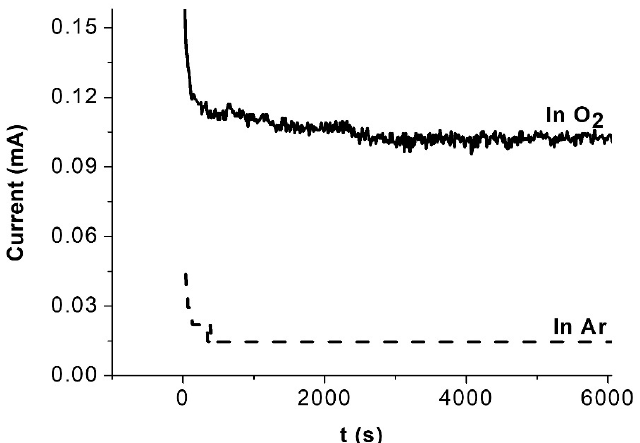
Figure 4. Potentiostatic stability tests of the Ni (20%)-NaPG/C catalyst on a CC electrode (S = 0.0707 cm 2 ) in 0.5 M H 2 SO 4 for 6000 s in both oxygen (solid, thick curve) and argon (dashed curve) saturated solutions at the same applied potential (E = − 0.15 V vs. Ag/AgCl) with 0.05 mg of the catalyst.